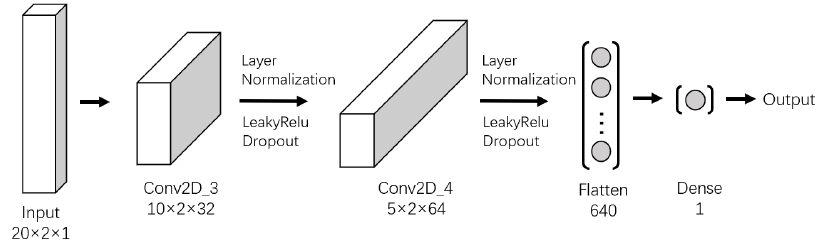
Figure 18. The structure of the generator for the Co-Varying Spiral problem.